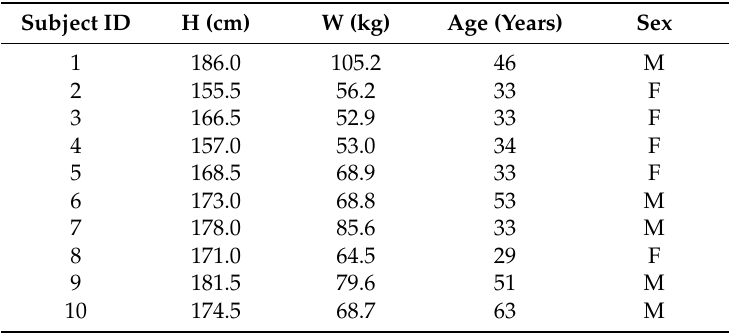
Table 3. Participants’